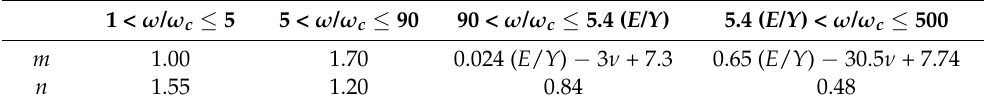
Table 5. Parameters in Equation (11). Figure 6. F / F c as a function of ω / ω c for different Y , ν , and E / Y ≤ 133.3: ( a ) E / Y = 133.3 and E / Y = 100; ( b ) E / Y = 79.4.